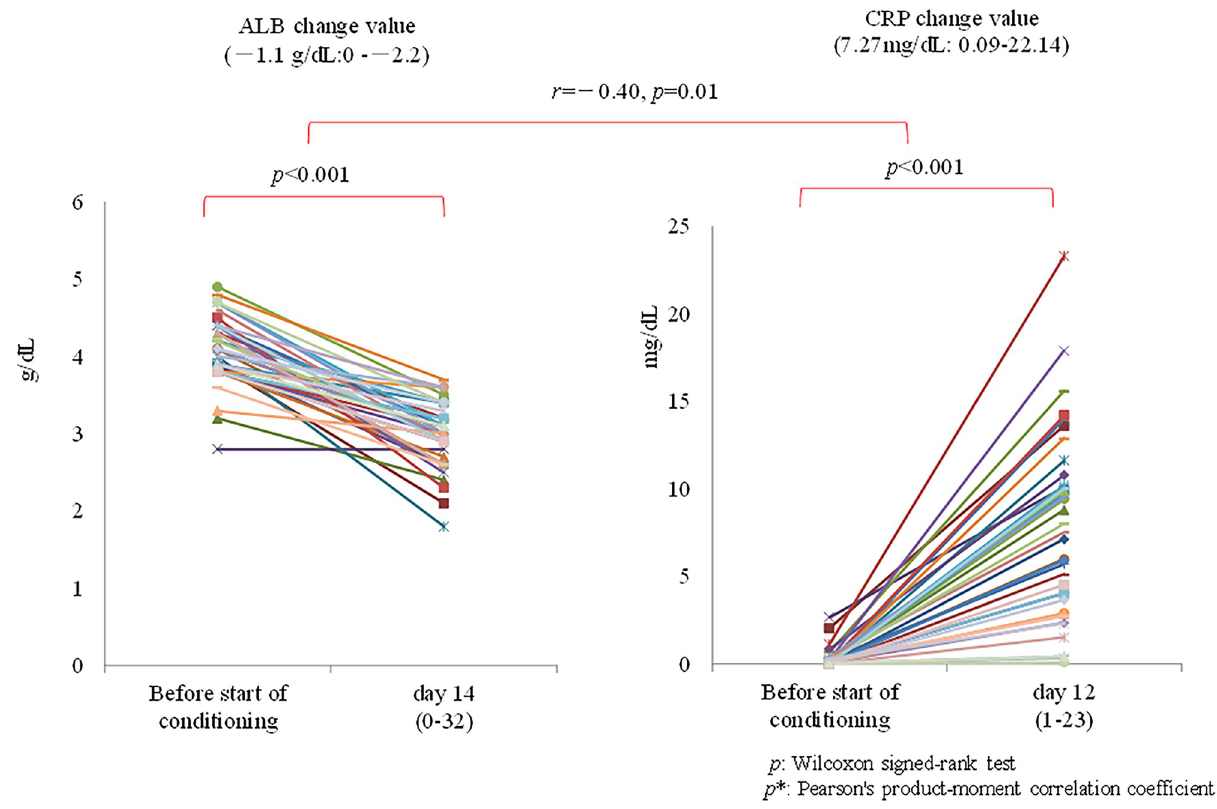
Fig 8. Changes in and associations with serum albumin and C-reactive protein